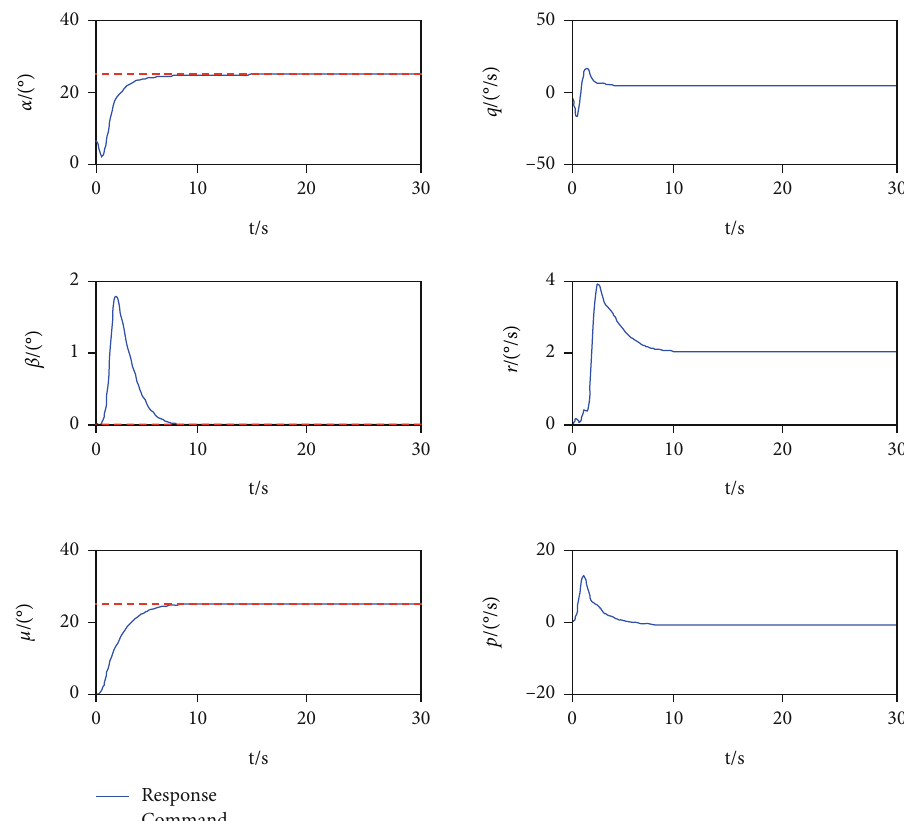
Figure 3: The state response of three-axis